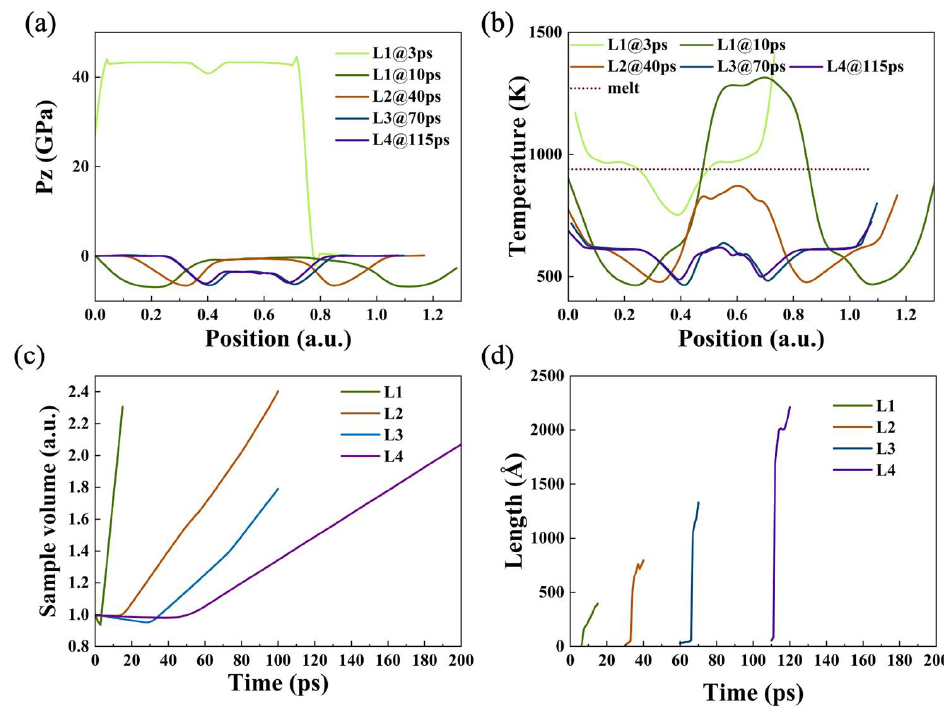
Figure 10. ( a ) Longitudinal stress profile and ( b ) temperature profile of L1 (3, 10 ps), L2 (40 ps), L3 (70 ps), and L4 (115 ps) at v 0 = 2 km/s. Evolution of ( c ) sample volume, and ( d ) damaged area width with time at v 0 = 2 km/s.